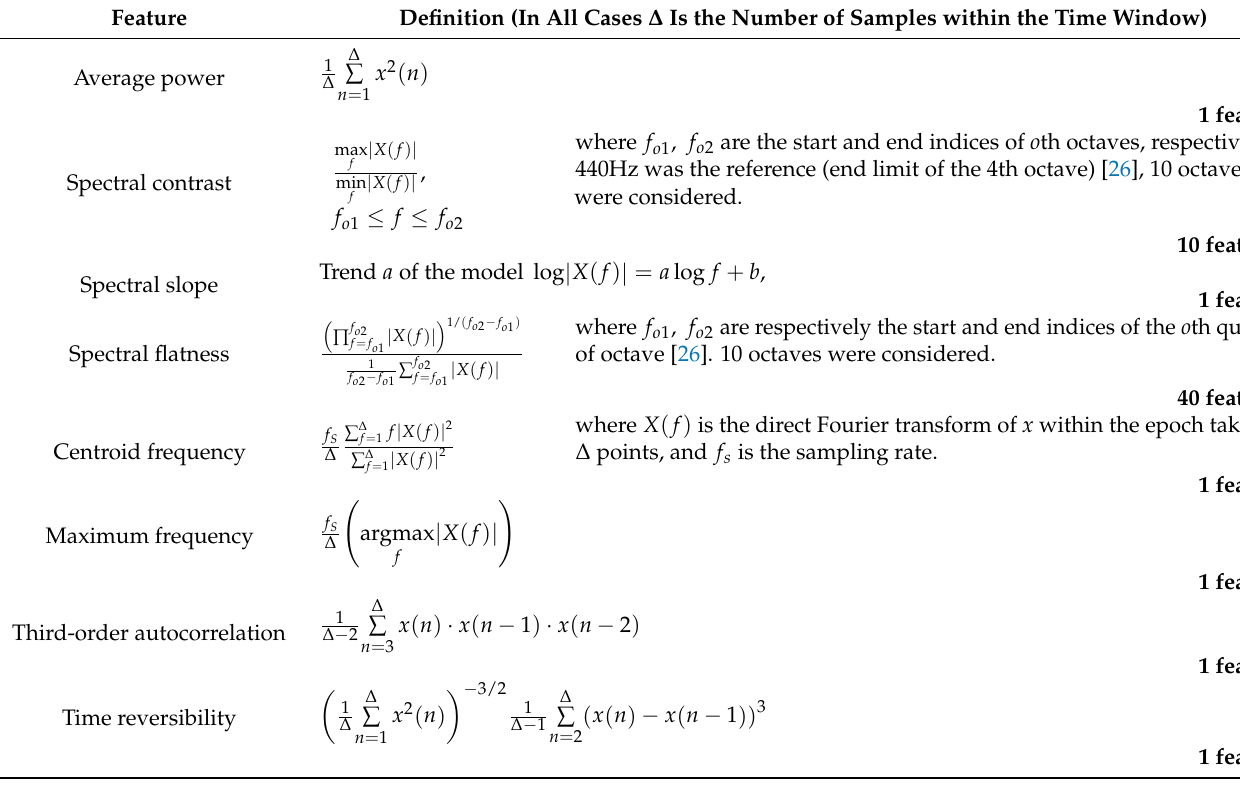
Table 1. Extracted feature